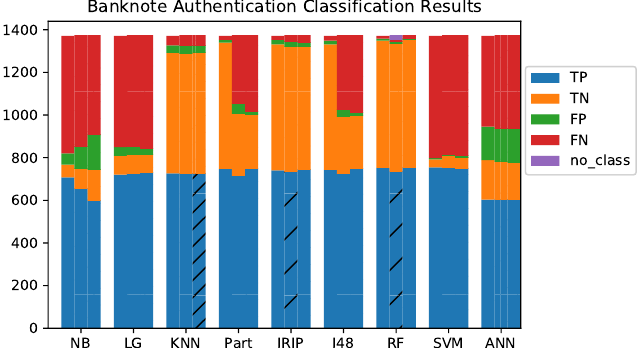
Figure A2. Graph corresponding to the Banknote Authentication dataset. In blue are true positives, in orange are true negatives, in green are false positives, in red are false negatives, and in purple are unclassified